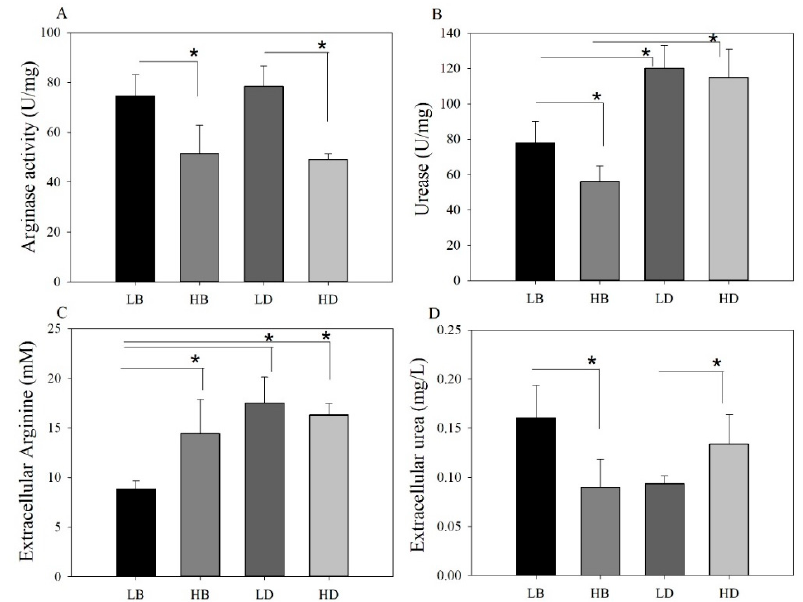
Figure 2. E ff ect of DAL80 deletion on the activity of arginase and urease enzymes, as well as the e ff ect on arginine and the extracellular urea concentration when yeast cells were cultivated under poor nitrogen conditions and rich nitrogen conditions. ( A ) Comparison of arginase activity when BY4741 and dal80 ∆ were cultivated under low nitrogen conditions and high nitrogen conditions (OD600